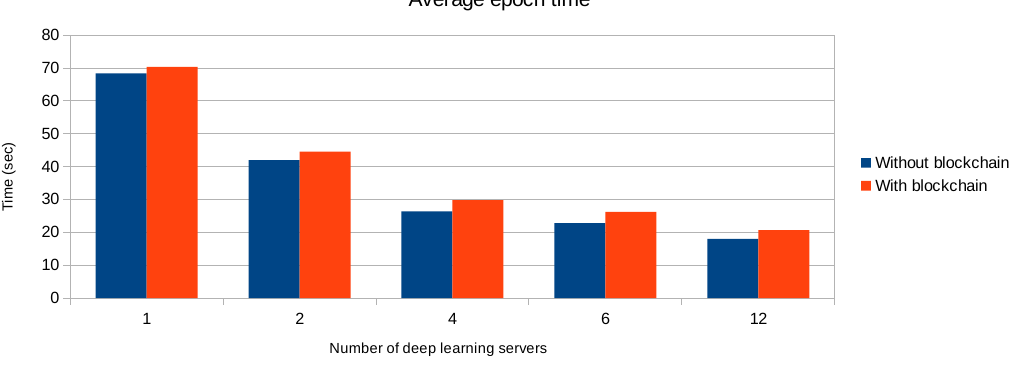
Figure 8. Average epoch time in seconds with and without the blockchain when the deep learning clients directly interact with the parameter